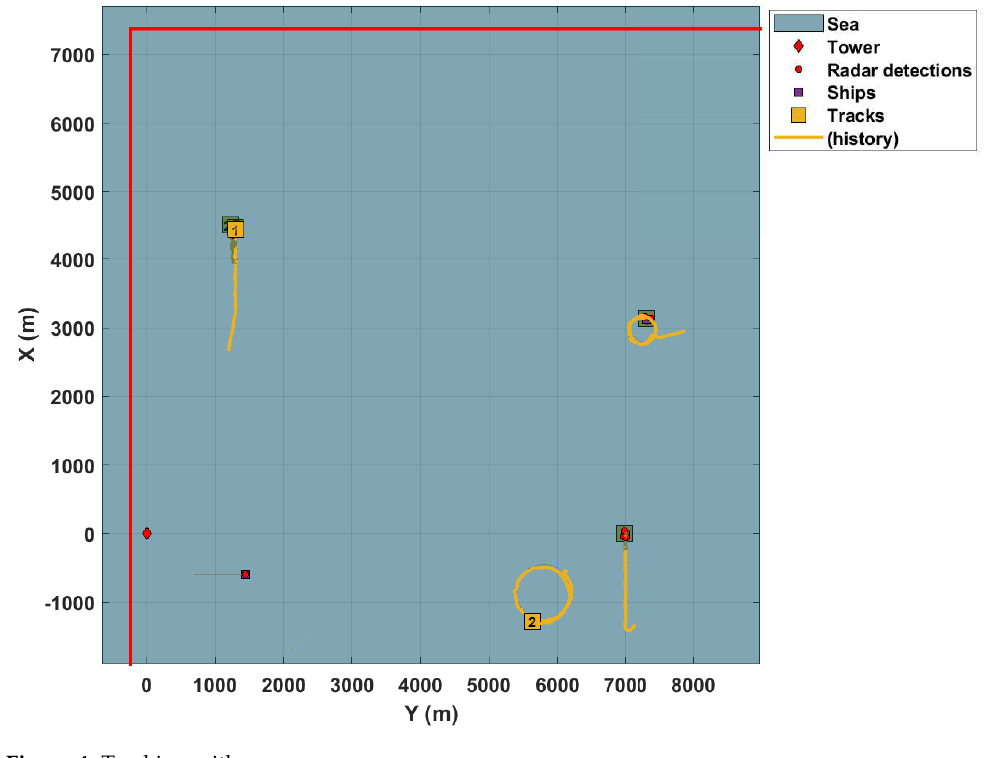
Figure 4. Tracking with one sensor.